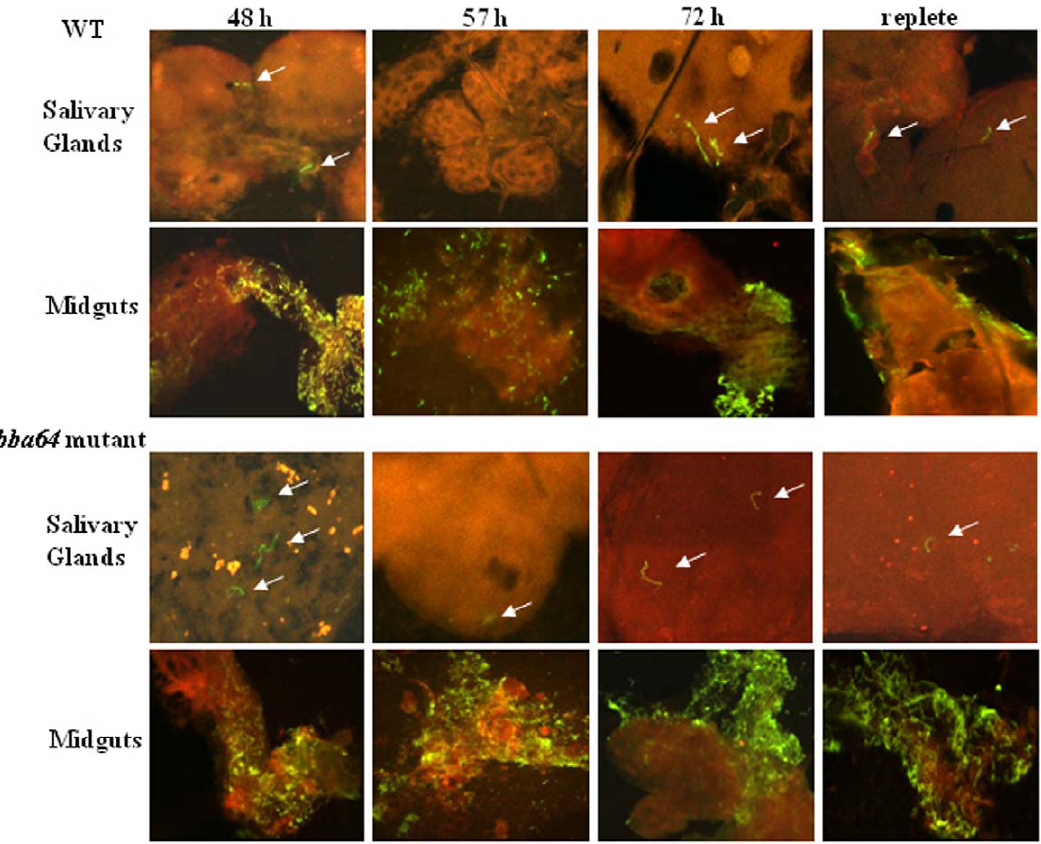
Figure 3. IFA confocal images of nymphal tick salivary glands and midguts. Representative images of salivary glands and midguts removed at 48 h, 57 h, 72 h post and repletion from WT- and bba64 mutant-infected nymphs. Arrows denote B. burgdorferi in salivary glands and the spirochetes in the midguts are represented by the yellow-green color. Magnification of salivary gland fields 400X; magnification of midgut fields 250X. The time point (h) at which the nymph was removed from the mouse is labeled above each composite.